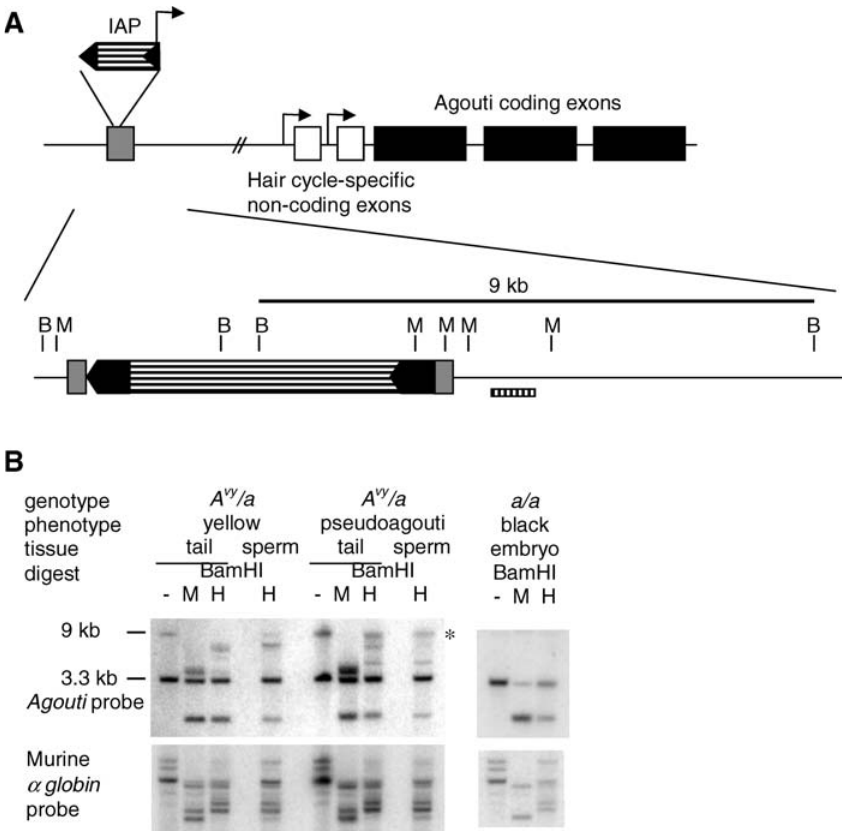
Figure 1. Methylation of the A vy Allele in Mature Sperm (A) Expression of the A vy allele is controlled by an IAP, inserted into pseudoexon 1a (grey box). A cryptic promoter within the 3 9 LTR of the IAP (black arrows) directs transcription of the agouti coding exons. The BamHI (B) and MspI (M) sites are shown in the region of the unique 400-bp probe B. Tail and mature sperm from a yellow and a pseudoagouti male were collected. DNA was prepared and samples digested with BamHI followed by MspI or its isoschizomer HpaII, transferred and hybridised with the agouti probe [3]. The A vy allele produces a 9-kb BamHI band, while the a allele produces a 3.3-kb band. Membranes were stripped and rehybridised with a murine a -globin probe to check for equal digestion within the tissue samples (shown in [B]). These results represent experiments performed on sperm and tail DNA from seven yellow and five pseudoagouti males, a further one of each are shown in Figure S1. Mature sperm were isolated from both epididymes of the male (each sample contained in the order of 10 6 to 10 7 spermatocytes). Sperm samples were checked by light microscopy and found to be greater than 95% spermatocytes. The methylation state of the tissues is indicated by the ratio of the 9-kb BamHI band to the 7-kb band remaining after HpaII digestion. The 9-kb band is marked by an asterisk. The methylation state of the sperm reflects the phenotype of the father rather than the range of phenotypes seen in the